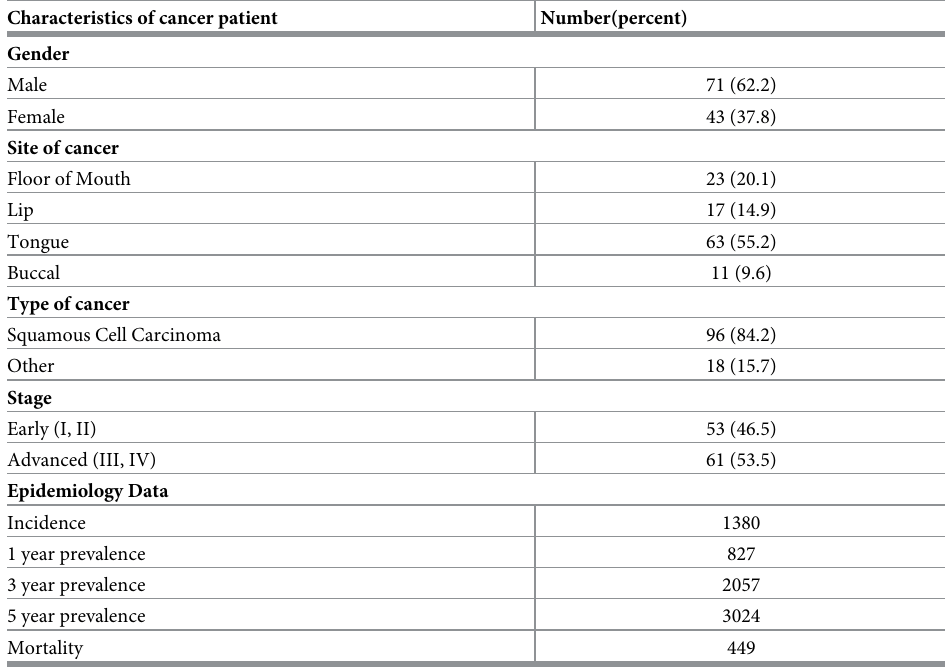
Table 1. Studied patient characteristics and epidemiological data of oral cancer 2014.